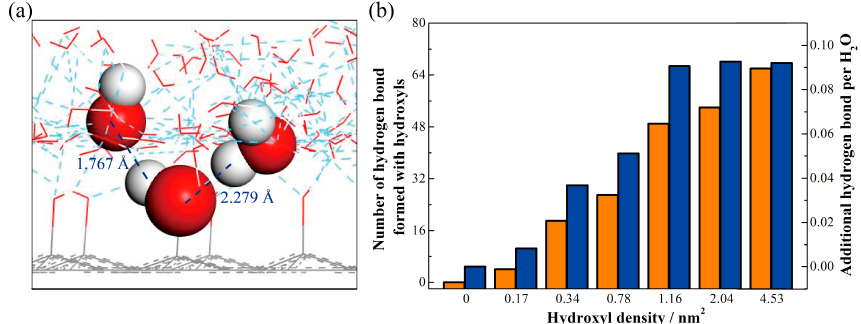
Figure 5. Details of hydrogen bonds formed between hydroxyls and water molecules. ( a ) Microscopic view of hydrogen bond formed between hydroxyls and water molecules; ( b ) Number of hydrogen bonds formed by hydroxyls (orange histogram) and additional hydrogen bonds per water molecule in adsorption layer (blue histogram).